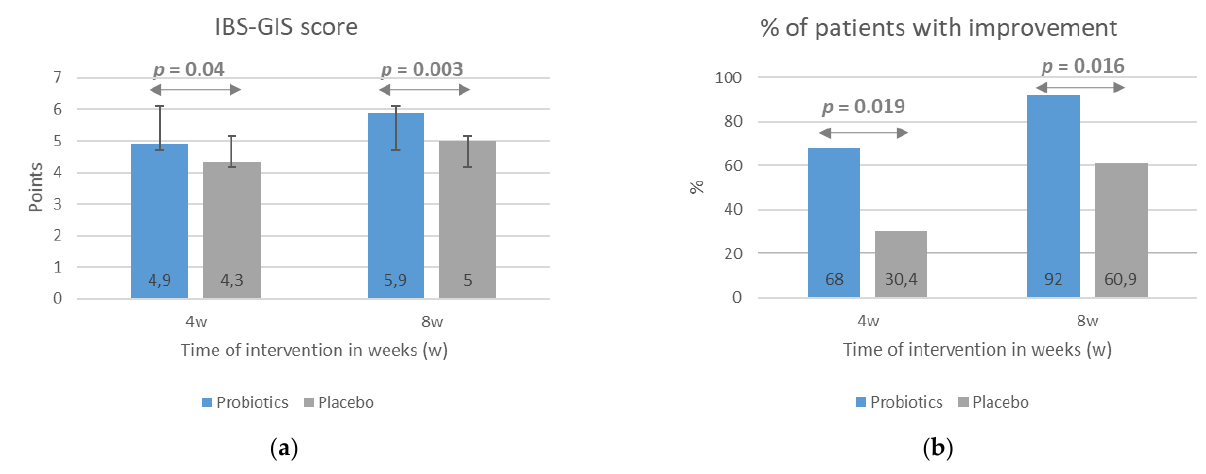
Figure 3. The effect of probiotic intervention on global IBS symptoms evaluated with the use the IBS-GIS. The IBS-GIS score ( a ) and an improvement in global IBS symptoms ( b ) were evaluated after 4 and 8 weeks of treatment. The results are presented as means ± SD of the IBS-GIS score ( a ) or the percentage of patients with an improvement in IBS symptoms ( b ). IBS-GIS scores >4 points indicated an improvement.